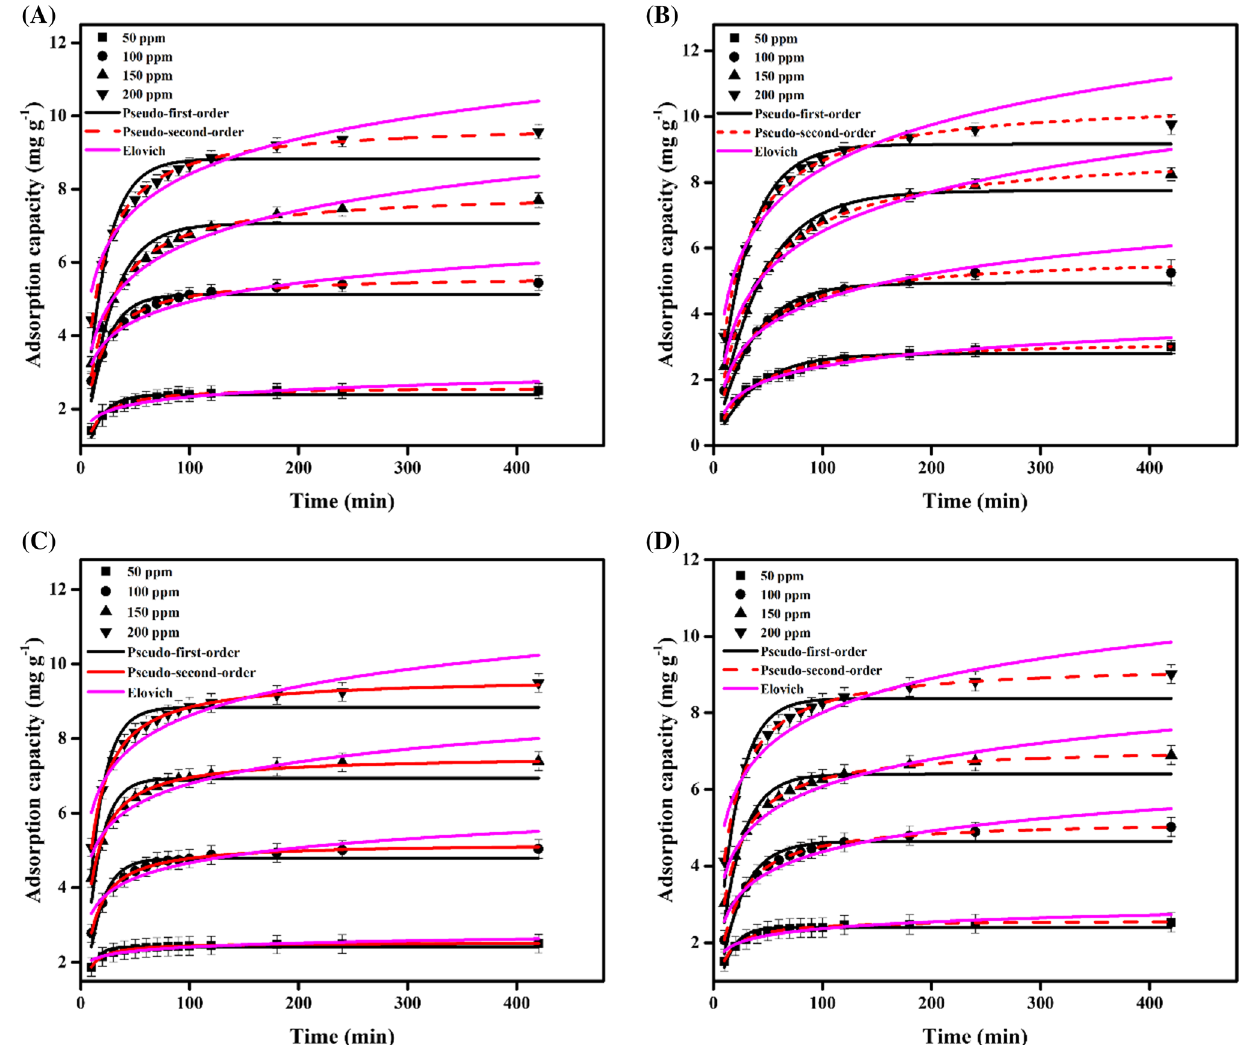
Fig. 3 Kinetic models of the adsorption of DR5B ( a ), DB22 ( b ), DB71 ( c ), and ( d ) RB5 onto spent mushroom